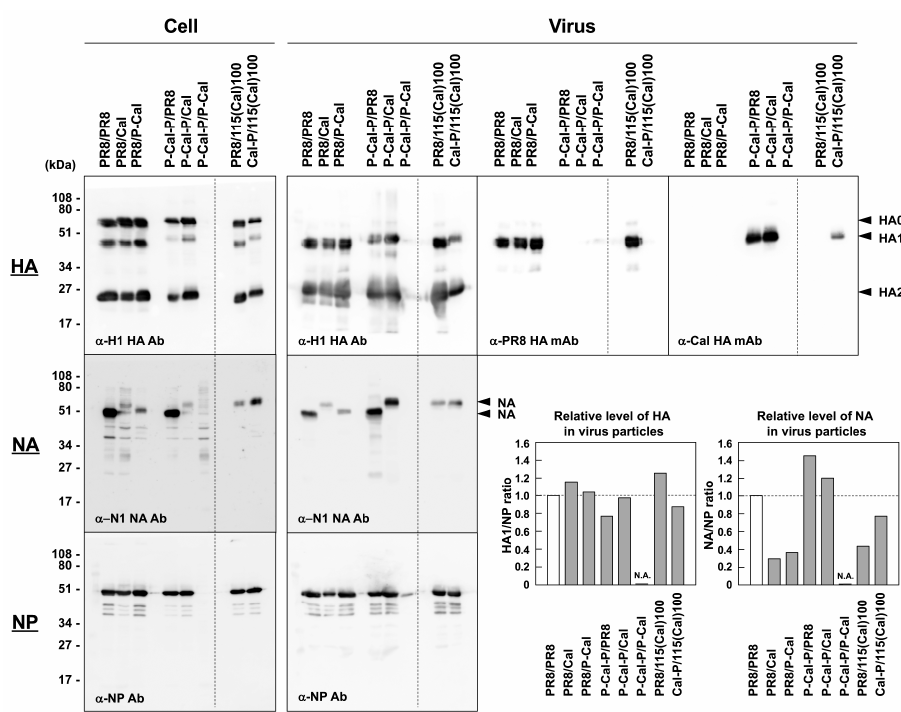
Figure 5. Relative protein levels in RG viruses with chimeric HA and NA. MDCK-1 cells were infected with RG viruses at a MOI of 1.0 and were incubated at 34 ◦ C for 1 d (2 days for P-Cal-P / P-Cal). The RG viruses in the culture media were concentrated through 20% sucrose cushions. The cell and virus samples were subjected to Western blotting with anti-H1 HA rabbit Ab, anti-PR8 HA mAb, anti-Cal HA mAb, anti-NA sheep Ab, and anti-NP rabbit Ab. Representative blots are shown. The band intensities in the virus samples proved by anti-H1 HA rabbit Ab, anti-NA sheep Ab, and anti-NP rabbit Ab were semi-quantified with ImageJ software. The levels of viral particles were normalized to the levels of NP in viral particle fractions. Relative levels of HA / NA in virus particles were evaluated as the ratio of HA / NA to NP. N.A.—not applicable.